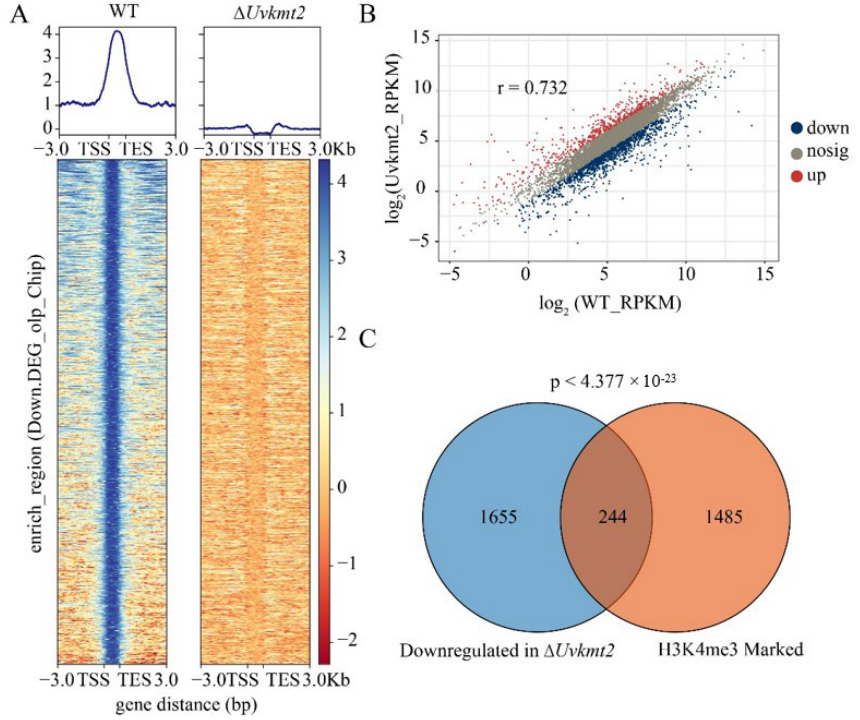
Figure 6. UvKmt2-mediated H3K4me3 plays a major role in transcriptional activation. ( A ) The average H3K4me3 occupancy within 3.0 Kb genomic regions flanking the summit of H3K4me3 peaks in the WT and ∆ Uvkmt2 strains. ( B ) Scatter plots reveal a positive correlation of up- and down- regulated genes between the ∆ Uvkmt2 and WT strains. Red dot, blue dot, and gray dot, respectively, represent an up-regulated gene, a down-regulated gene, and a gene without significant change. The RPKM for the ∆ Uvkmt2 was plotted against biological WT, demonstrating that three biological replicates are correlated. r is the correlation coefficient. ( C ) The overlapping between down-regulated genes in ∆ Uvkmt2 versus WT and H3K4me3-marked genes was presented by Venn